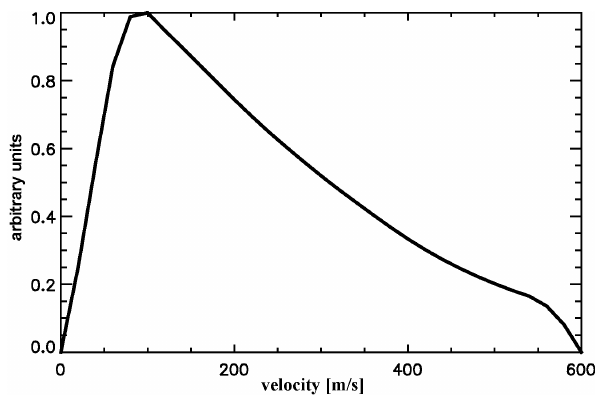
Fig. 6. Normalized mean velocity distribution between 0 and 600m.s − 1 calculated from the database used in Valli`eres et al. (2003) and averaged over the 4 radar frequencies and all radar ranges.